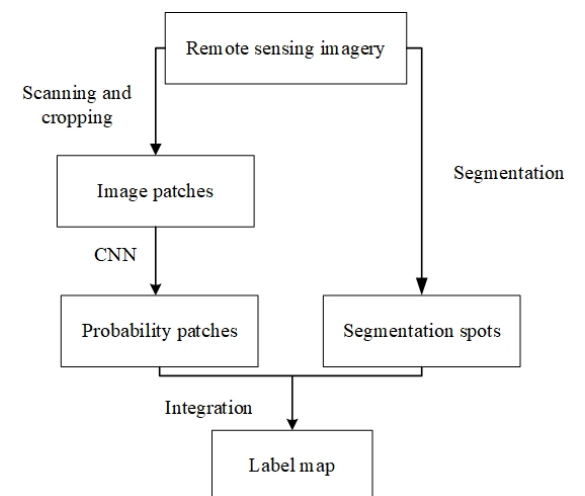
Figure 1. Workflow map (modified from Yuanming Shu, 2014). Multi-scale segmentation method is used to segment the remote sensing imagery into segmentation spots, which will be unit for integrate the probability. During the segmentation process three key parameters (scale parameter, image layer weights, composition of homogeneity criterion) will be